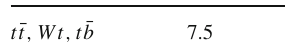
Table 9 Uncertainties in the normalisations of the different backgrounds for all processes, as derived from the total cross-section